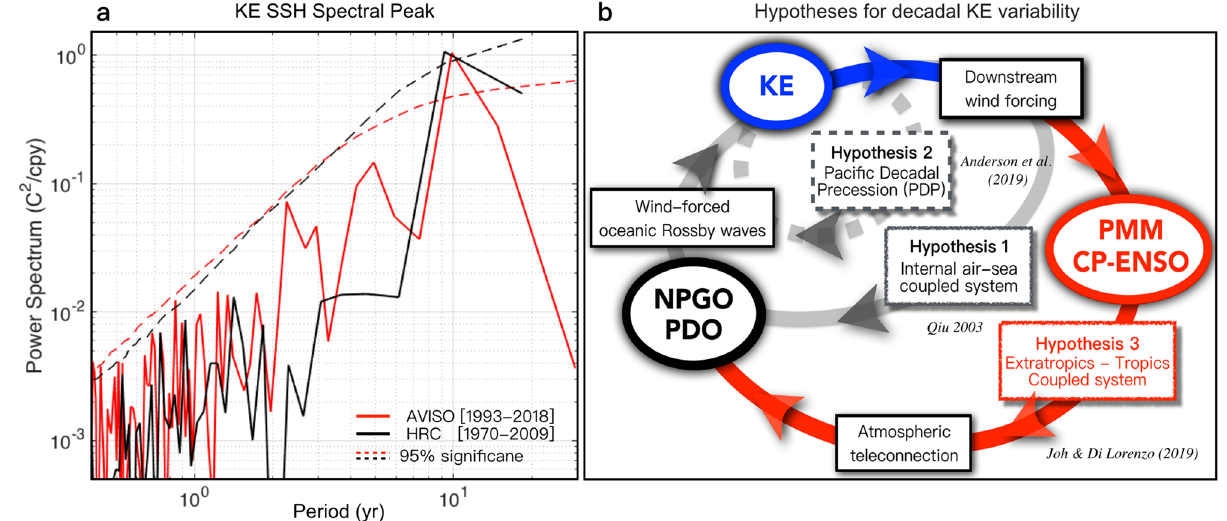
Figure 1. The preferred spectral peak of the KE index and diagram of the proposed hypothesis for generating decadal KE variability. ( a ) Power Spectrum as a function of the SSH-based KE index period (year) from the observations and HRC with 95% significance levels. ( b ) Internal air-sea coupled KE system (KE → KE downstream response → PDO/ NPGO → KE, hypothesis 1 17 ), Pacific Decadal Precession KE system (KE → north–south teleconnection phase → east–west teleconnection phase → KE, hypothesis 2 19 , and extratropical-tropical coupled KE system (KE → KE downstream response → PMM/CP-ENSO → NPGO/ PDO → KE, hypothesis 3 20